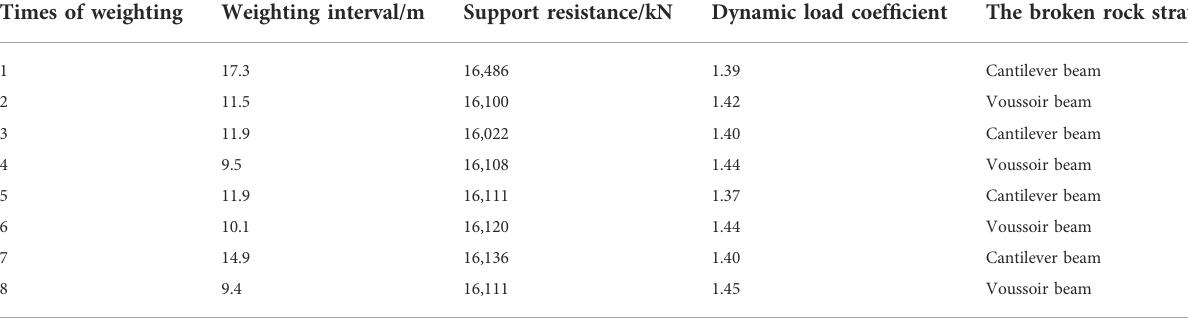
TABLE 7 The weighing characteristic of no.60 support in 31,206 working face. Times of